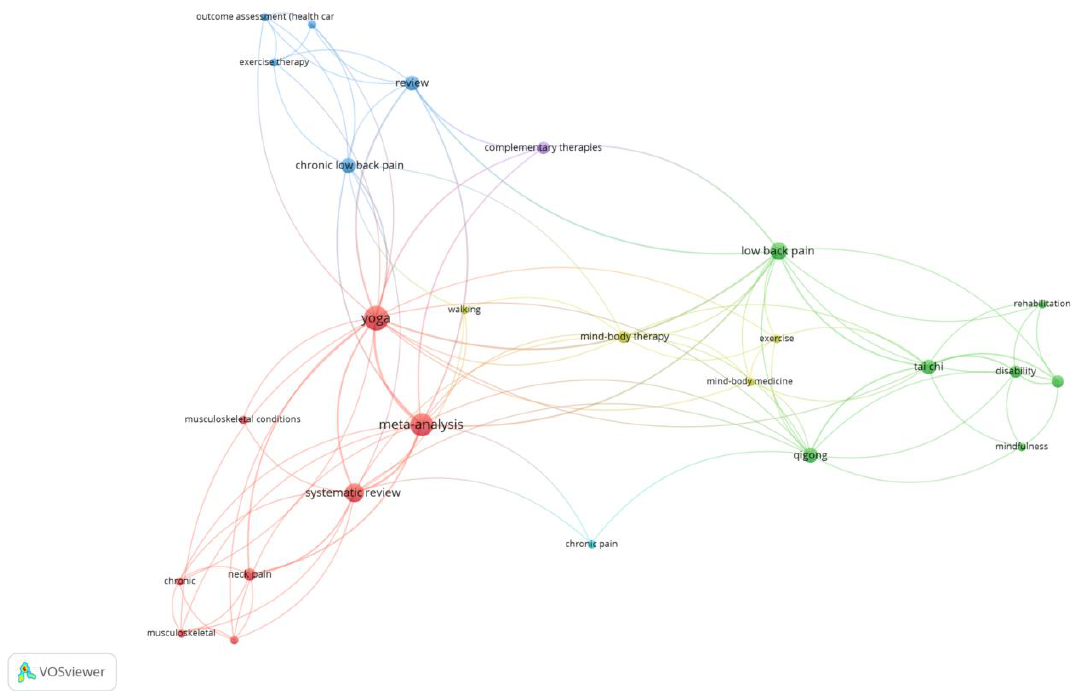
Figure 2. Network Visualization .